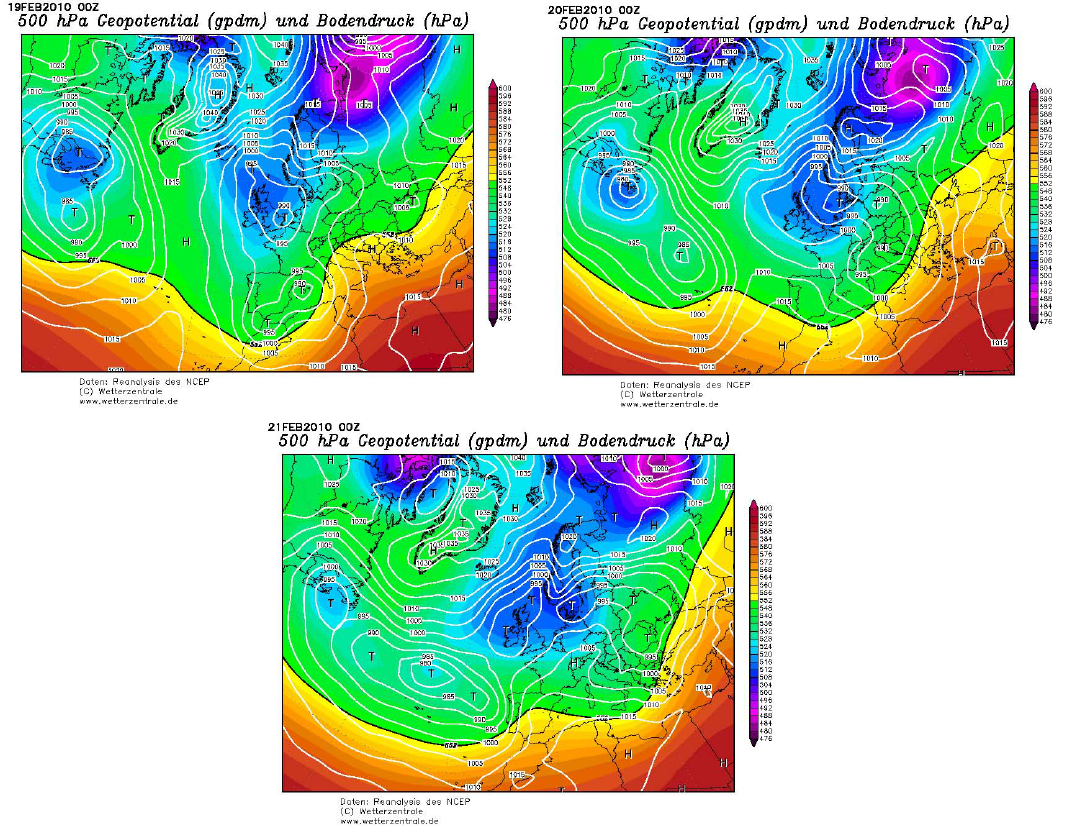
Fig. 9. Geopotential height at 500hPa and mean sea level pressure at 00:00 UTC between the 19 and 21 February 2010 (http://www.osdpd. noaa.gov/ml/ocean/sst/anomaly